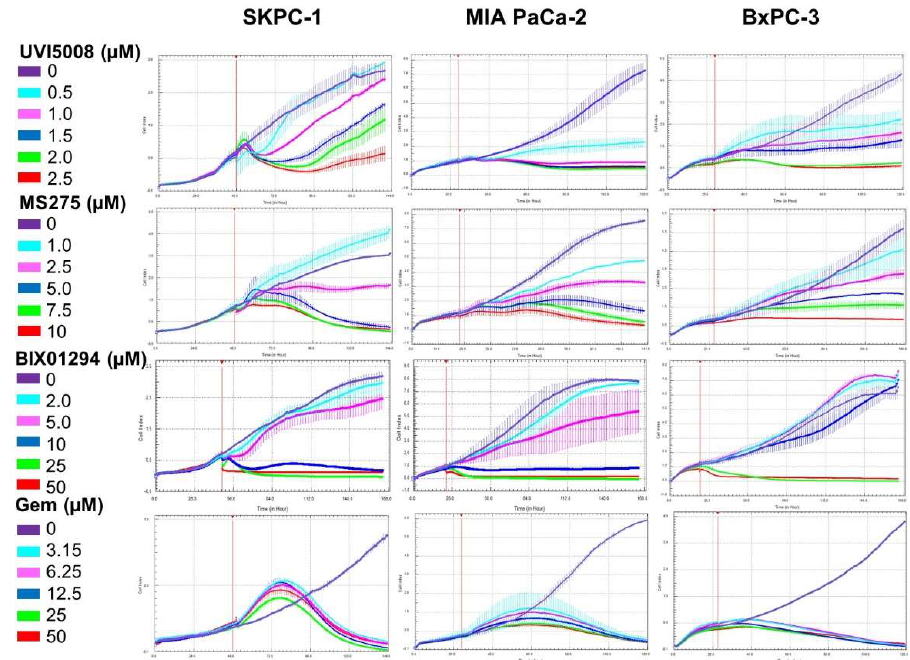
Figure 2. Kinetics of the cell viability of SKPC-1, MIA PaCa-2, and BxPC-3 cells incubated with the epigenetic inhibitors UVI5008, MS275, and BIX01294 or gemcitabine (Gem). The treatments were added after cell stabilization (vertical red lines). Cell viability was monitored with an impedance- based real-time cell analyzer.